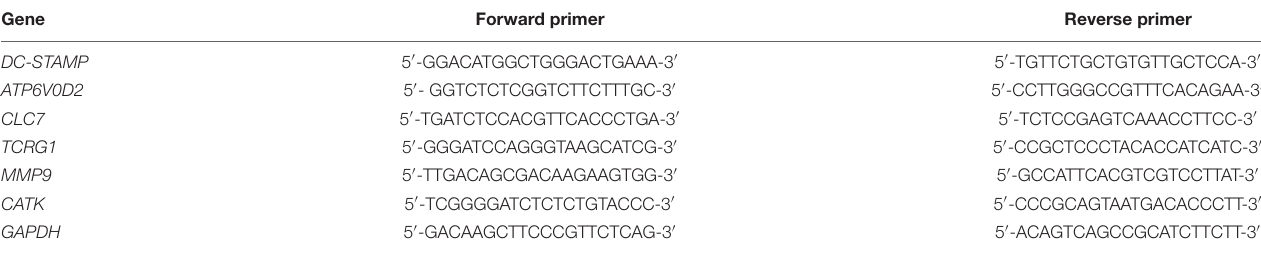
TABLE 1 | List of primer pairs and sequence. Gene Forward primer Reverse primer